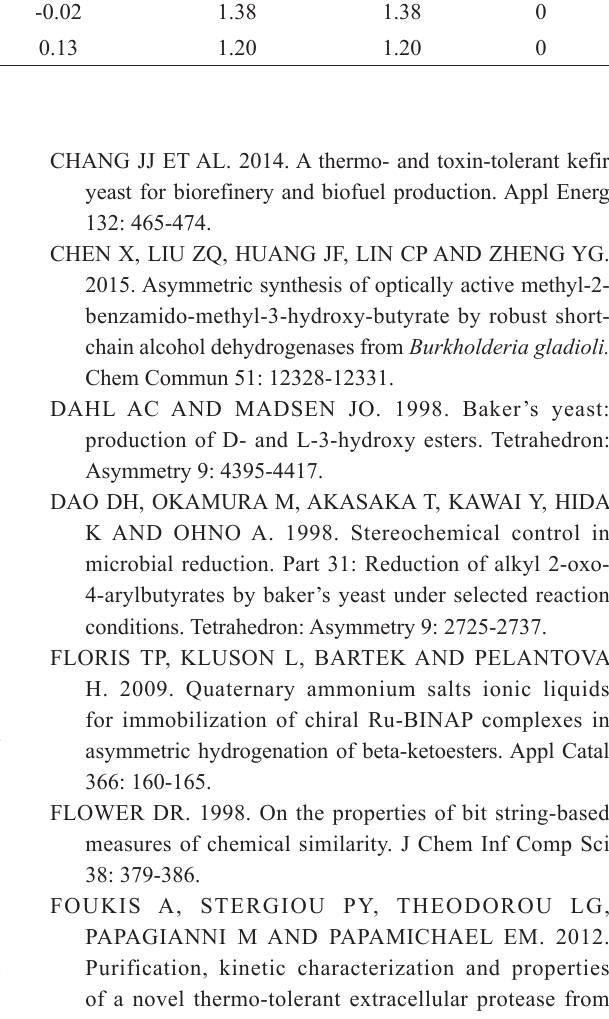
β-KETOESTERS: AN APPROACH FOR ASYMMETRIC BIOREDUCTION